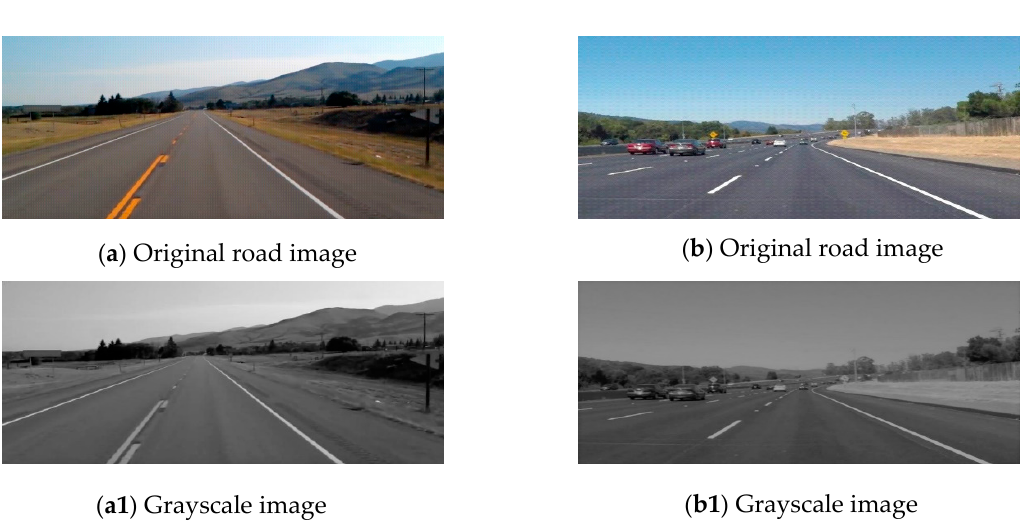
Figure 2. The original road input images ( a , b ) and the output grayscale images ( a1 , b1 ) are shown.